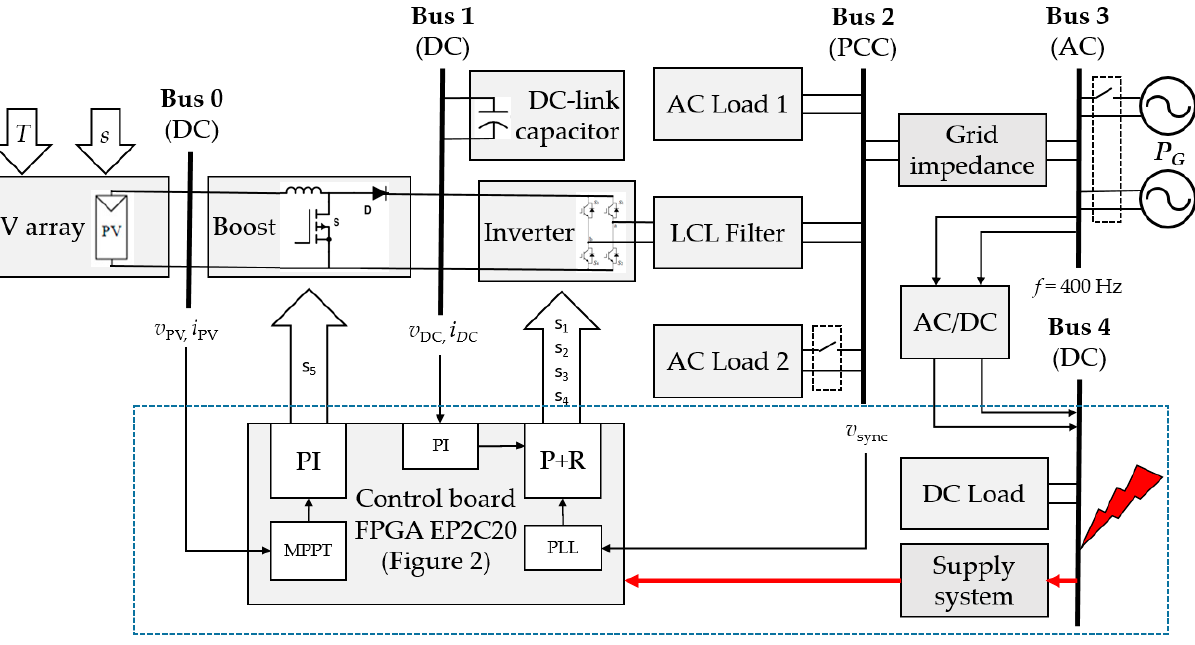
Figure 1. Block diagram of the system under study that includes the grid converter, photovoltaic panels, on-board grid, additional loads, control device, and power system for electronic systems.